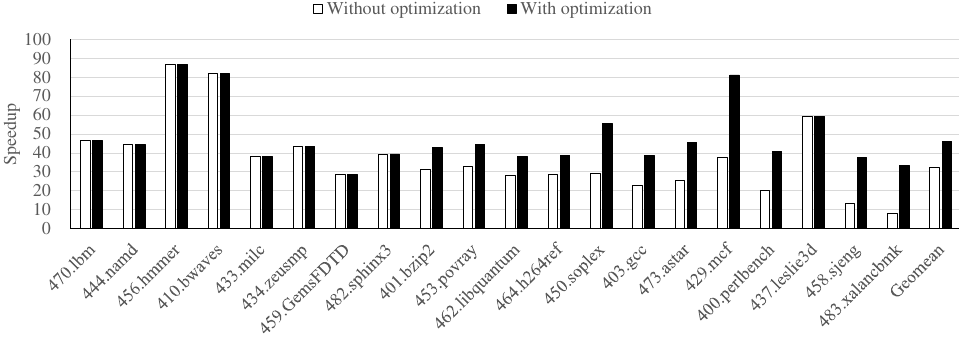
Figure 14. Performance improvements via task management optimization when using 256